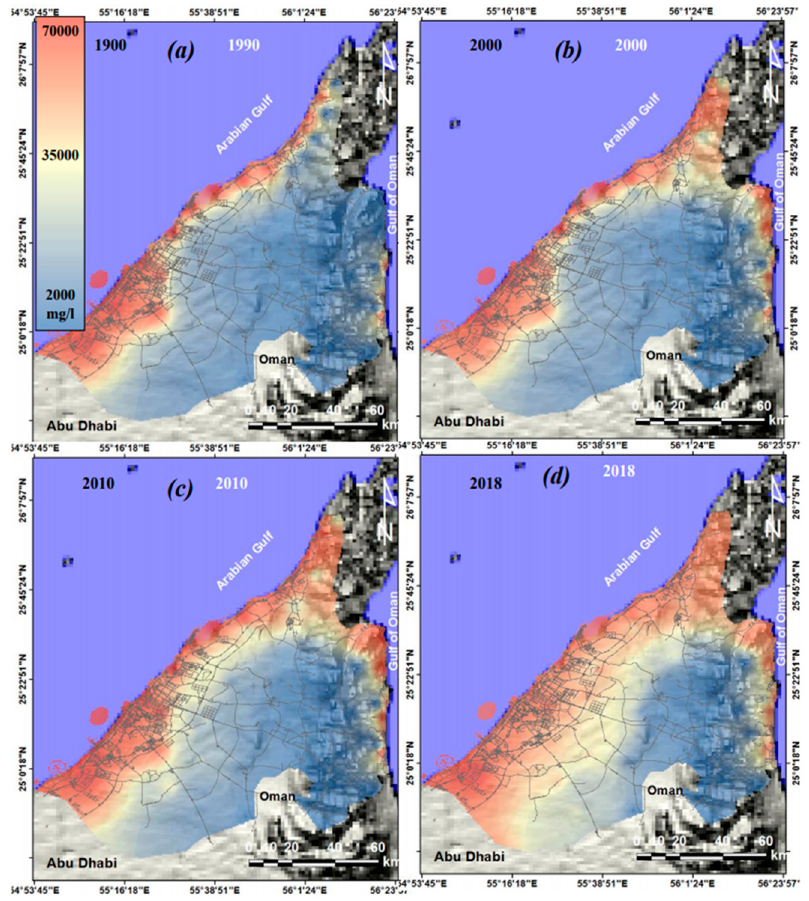
Figure 12. Regional spatiotemporal variations of TDS concentration in groundwater wells across the study area for the years 1990, 2000, 2010, and 2018.